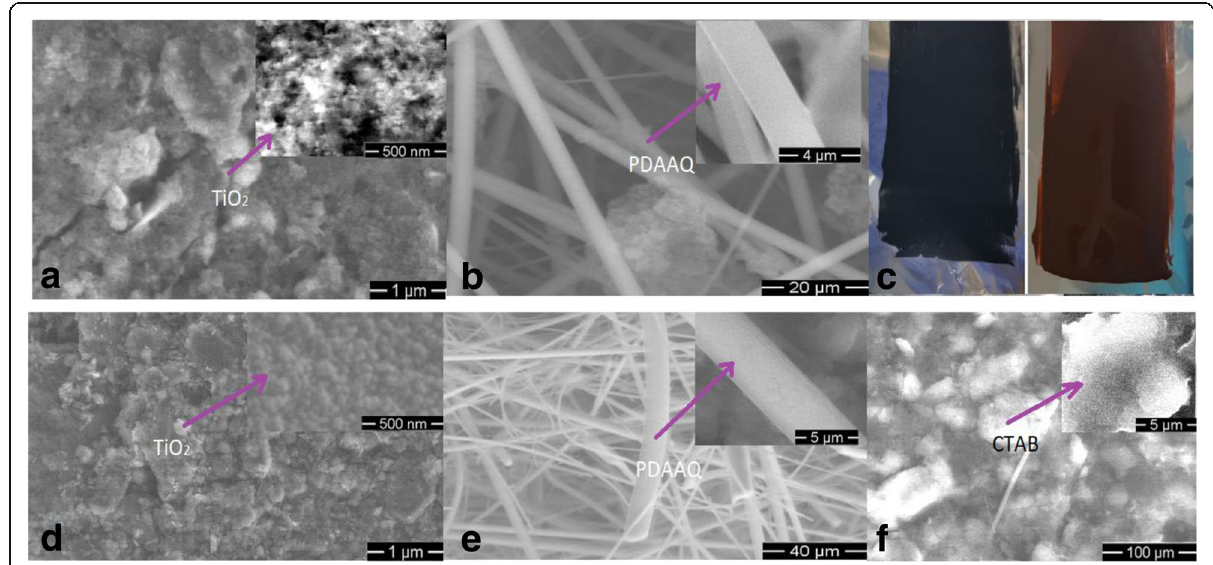
Fig. 2 SEM images of a TiO 2 /PC-FGF/S cathode and b PDAAQ/PC-FGF/S cathode, the insets are high-resolution images. c Photographs of TiO 2 / PC-FGF/S (left) and PDAAQ/PC-FGF/S (right) cathode, SEM images of d TiO 2 /MWCNT/PC-FGF e PDAAQ/PC-FGF, f PDAAQ/CTAB/PC-FGF coated glass fiber separators, the insets are the high-resolution